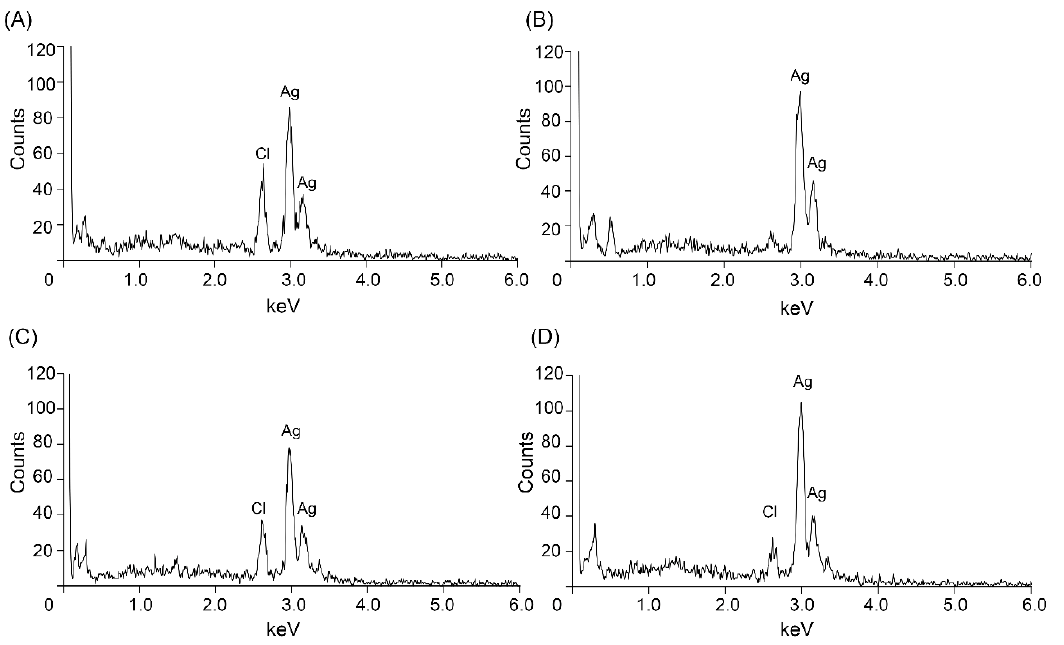
Figure 3. Energy-dispersive X-ray spectrometry spectra of Ag/AgCl NPs synthesized using ( A ) su- pernatant of Bti ; ( B ) solubilized inclusion proteins of Bti (mix toxins); ( C ) solubilized Cry4Aa protein; ( D ) solubilized Cry4Ba